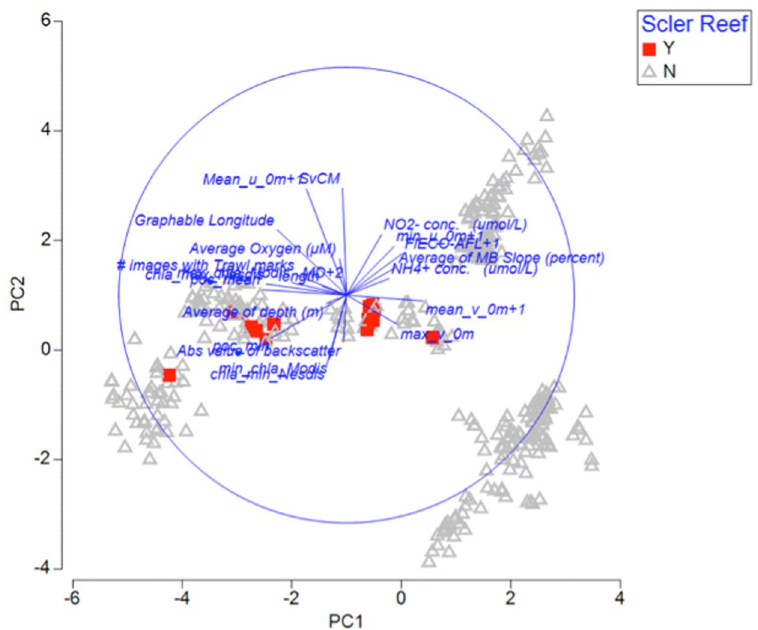
Figure 5. PCA plot of available environmental data after removal of variables that were more than 90% correlated. Each point represents a single 1 km AUV